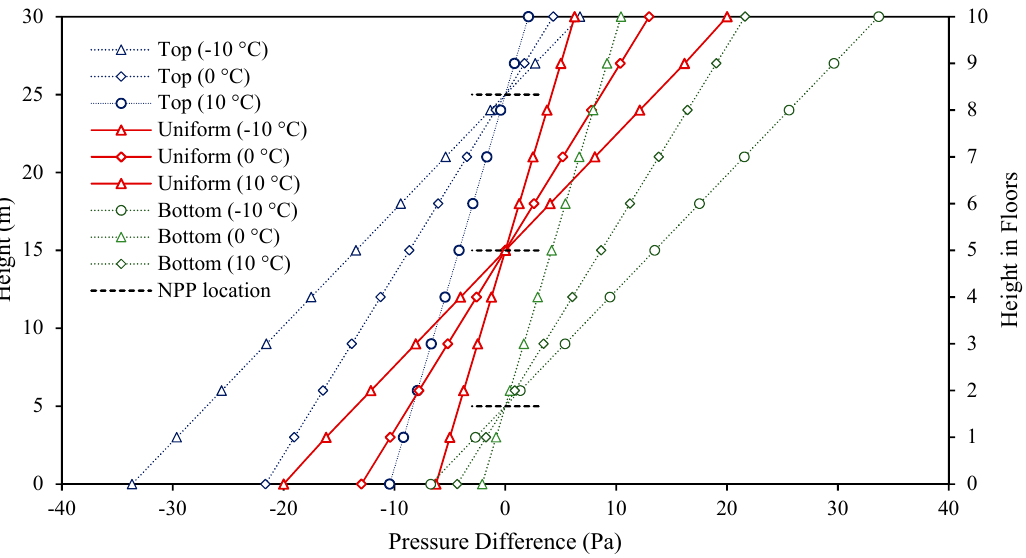
Figure 1. Stack pressure of a vertical shaft of 20 °C for variations in ambient temperature ( − 10, 0, 10 °C) and leakage distribution (top, uniform, bottom).